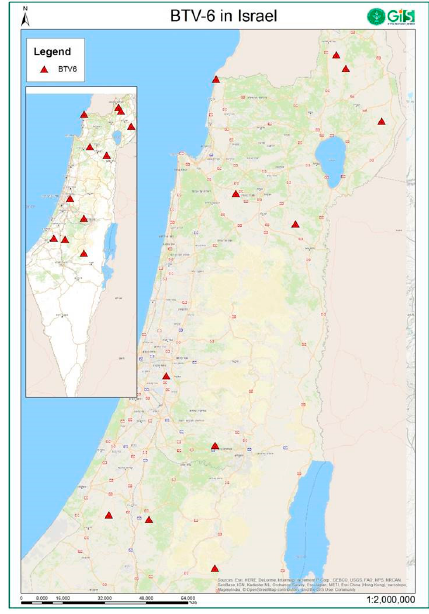
ff ected sheep and cattle farms, Figure 1. Location of BTV-6 affected sheep and cattle farms, Israel. Figure 1. Location of BTV-6 a